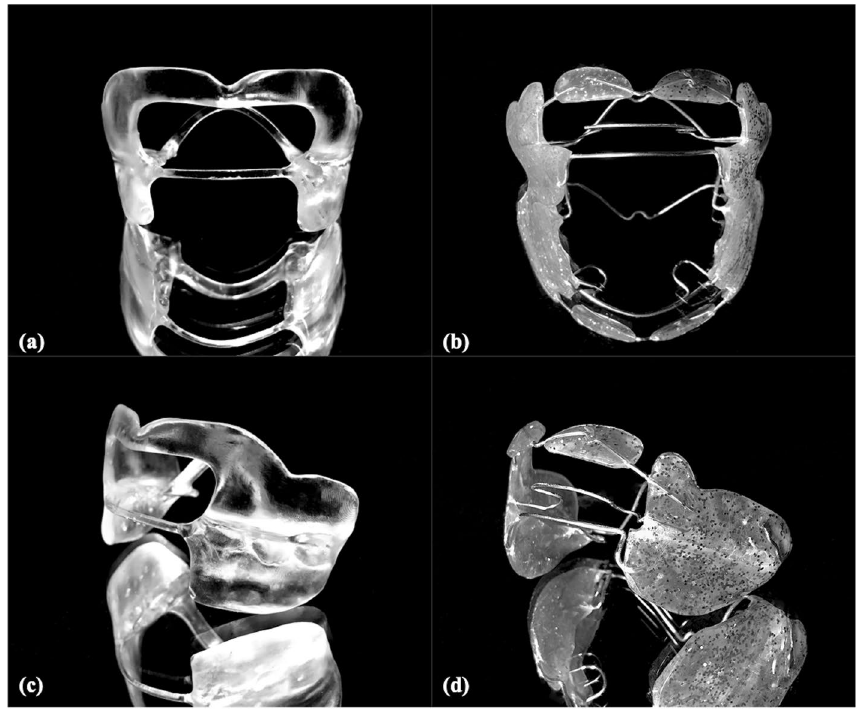
Figure 2. CAD/CAM function regulator 3 (CAD-FR3; a , c ) and conventional FR3 (Con-FR3; b , d ). Unlike the Con-FR3s, the CAD-FR3s had a vestibular shield of a one-piece design. In addition to increasing stability, this design was intended to increase the tension points on the periosteum and thus have an even greater effect on maxillary post-development. The CAD-FR3s were monolithic and therefore constructed with no metal